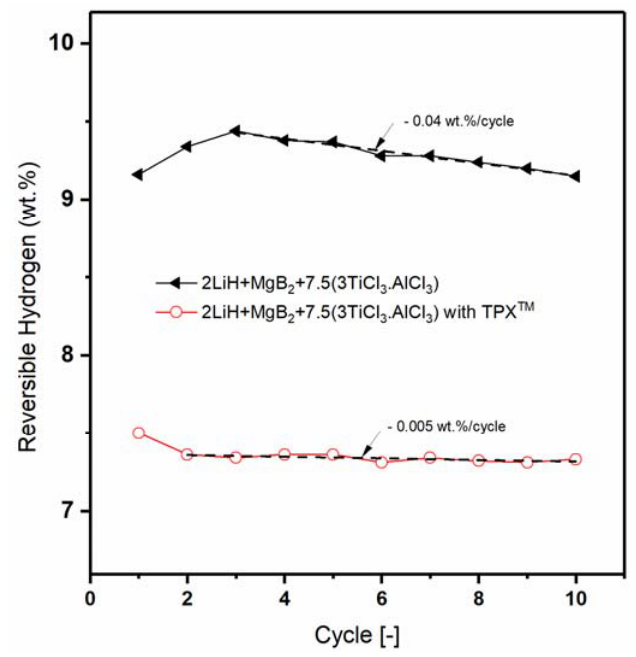
Figure 3. Reversible hydrogen capacity for dehydrogenation over the cycling of the confined and non ‐ confined Li ‐ RHC d +7.5(3TiCl 3 ∙ AlCl 3 ) materials.